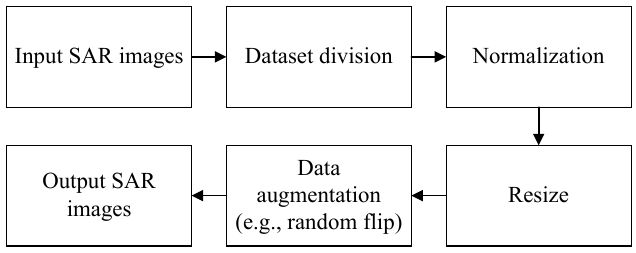
Figure 9. A flow chart of pre-processing for SAR images. Table 1. Statistics of SSDD and HRSID